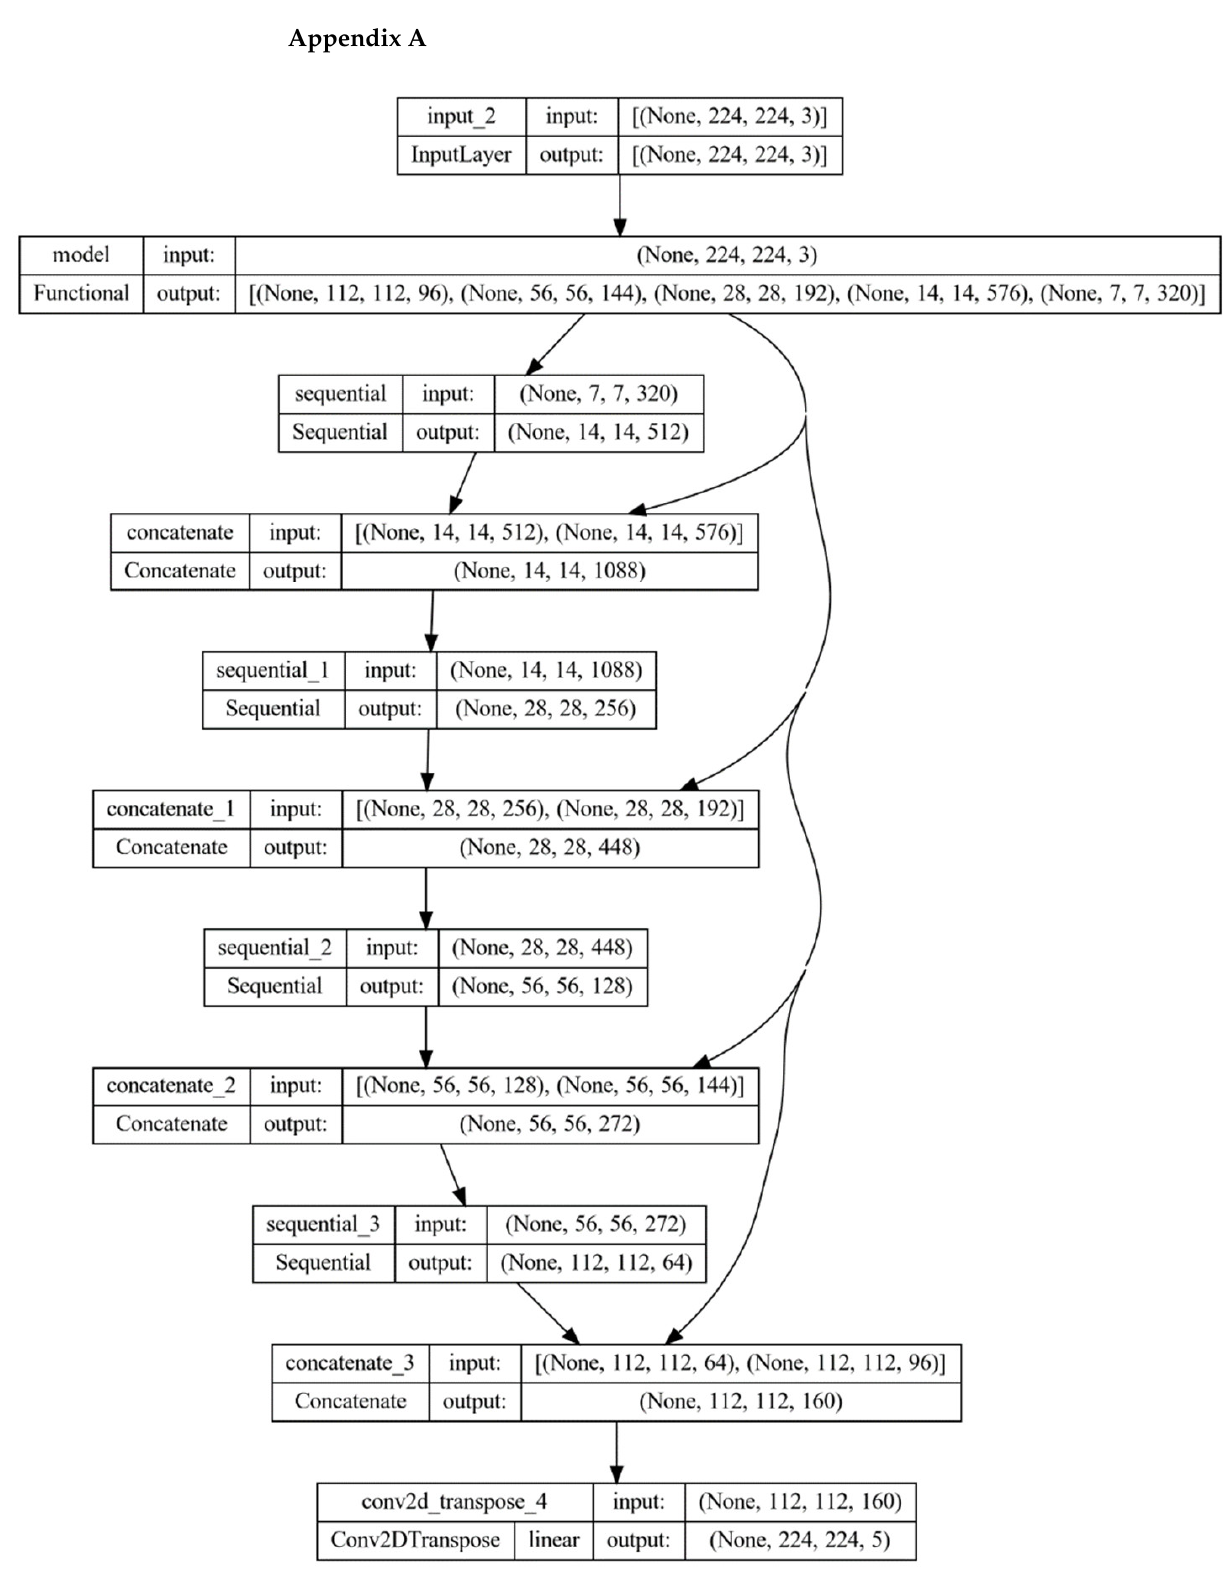
Figure A1. Segmentation model architecture with one data source as input.